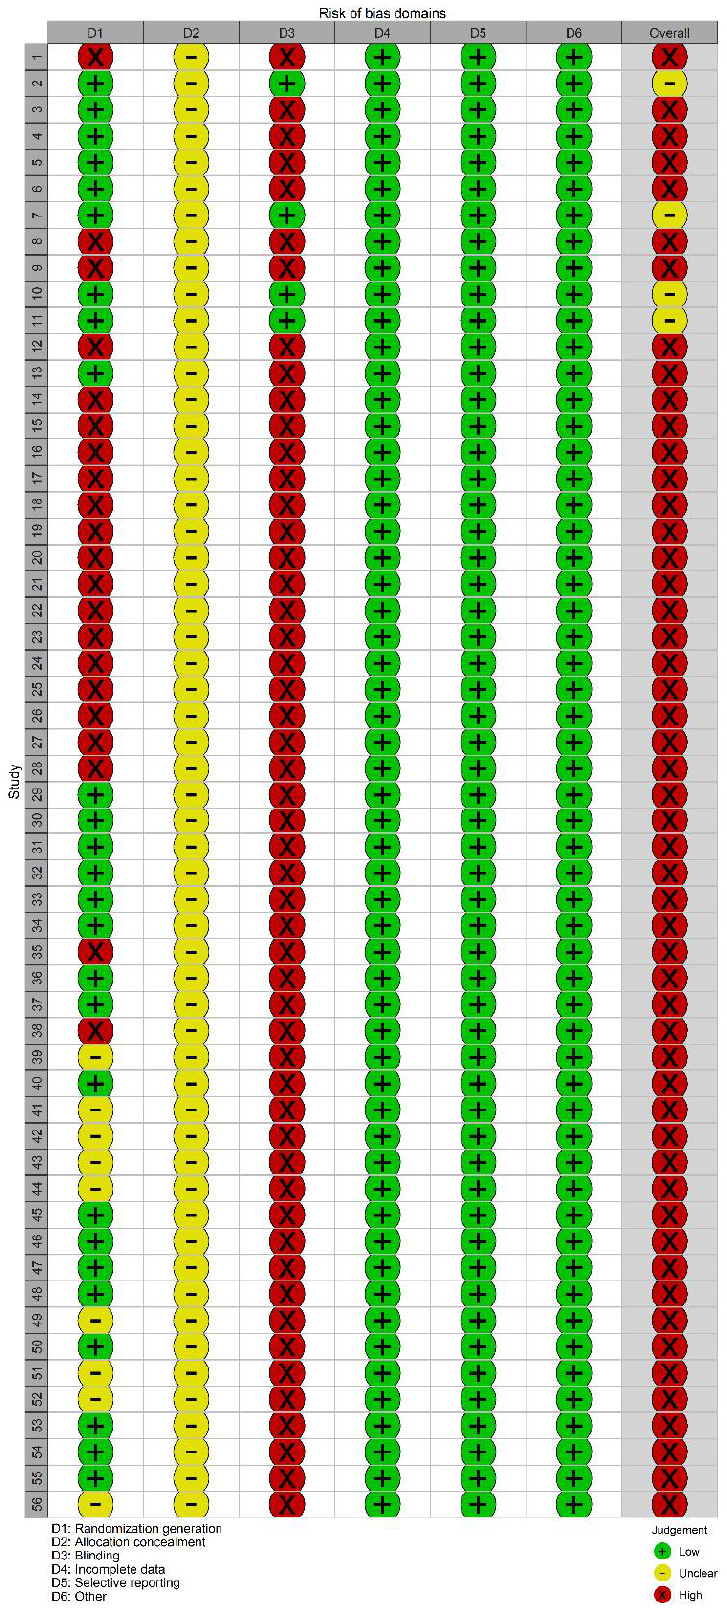
Figure 3. Risk of bias summary.